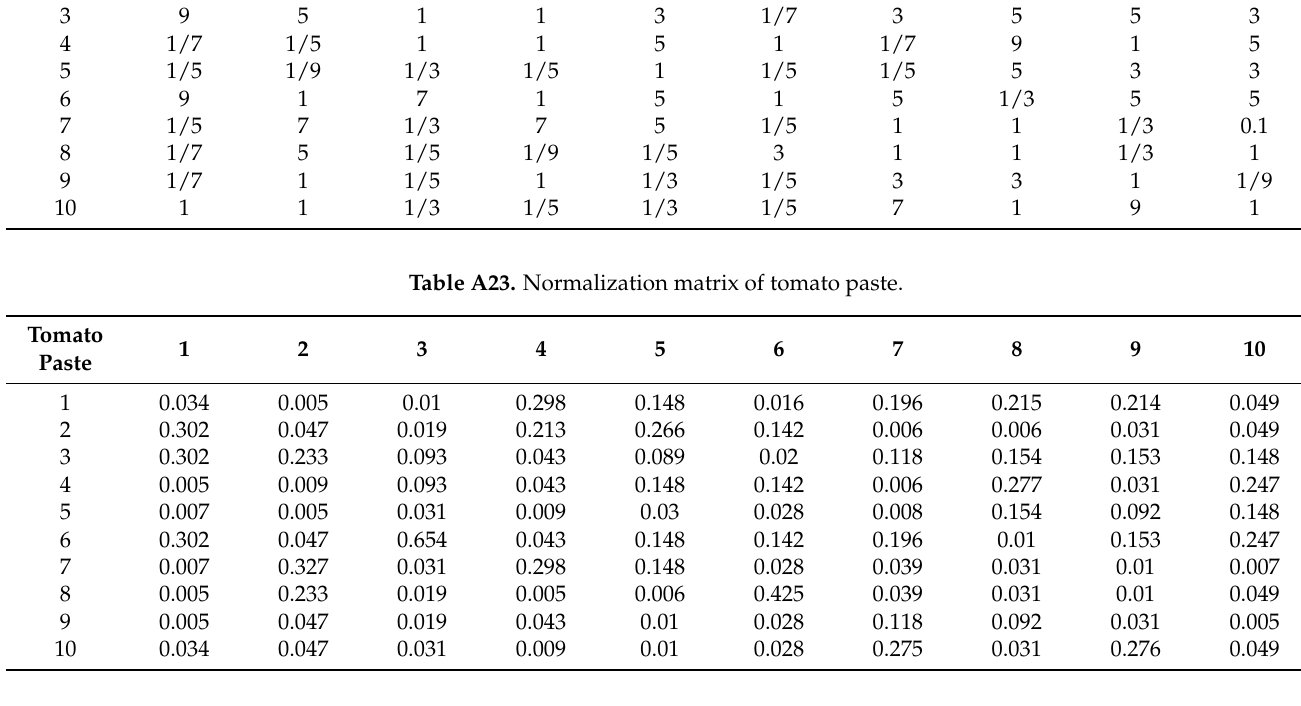
Table A24. Weight of each criterion for tomato